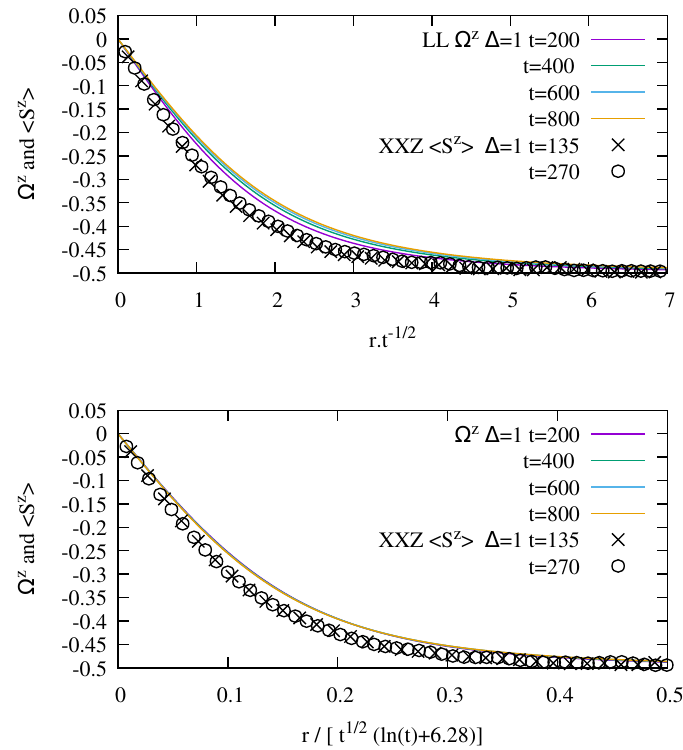
Figure 10: Ω z magnetization profile for LL at ∆ = 1, and comparison with 〈 S z 〉 in the XXZ chain (tDMRG simulations L = 800 sites, maximal bond dimension χ = 2000 (cid:112) t in the top panel, and r / g ( t ) with and time t = 270). The horizontal axis is r / (cid:112) g ( t ) = t [ ln ( t ) + 6.28 ] in the lower panel. The latter, gives a good collapse of